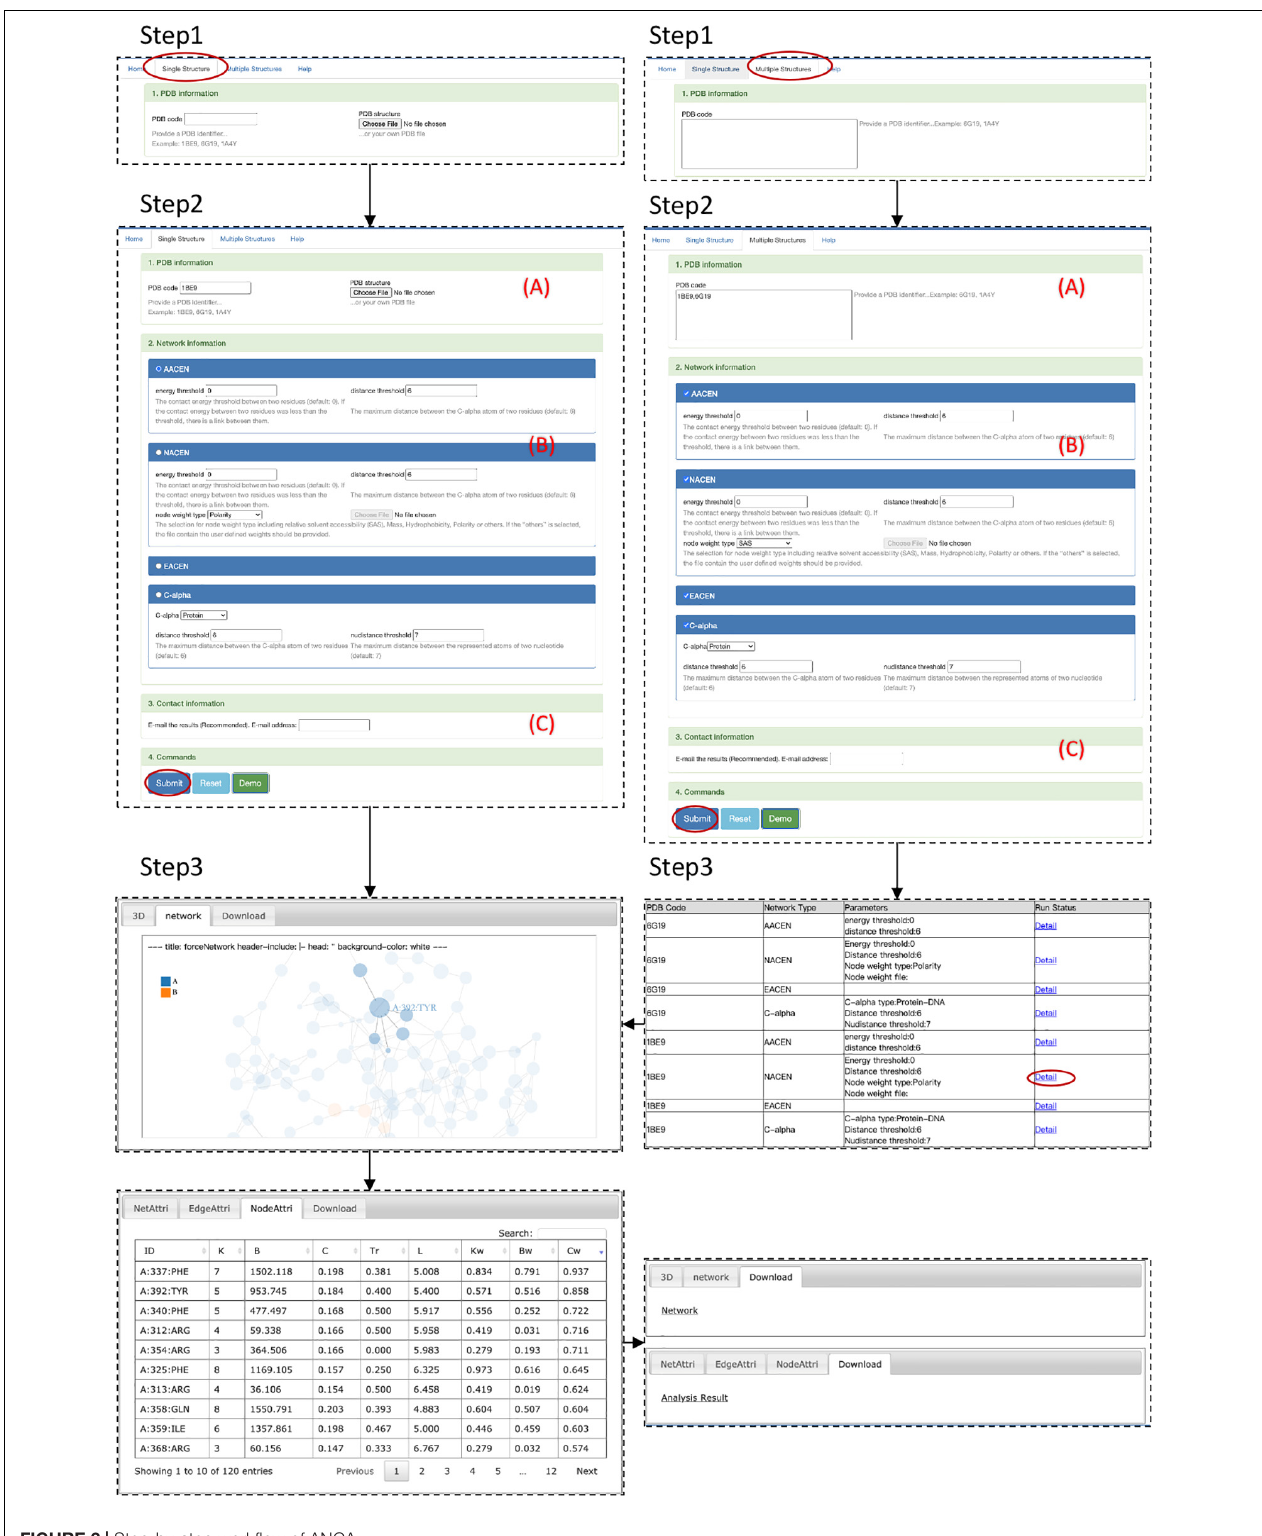
FIGURE 2 | Step-by-step workflow of